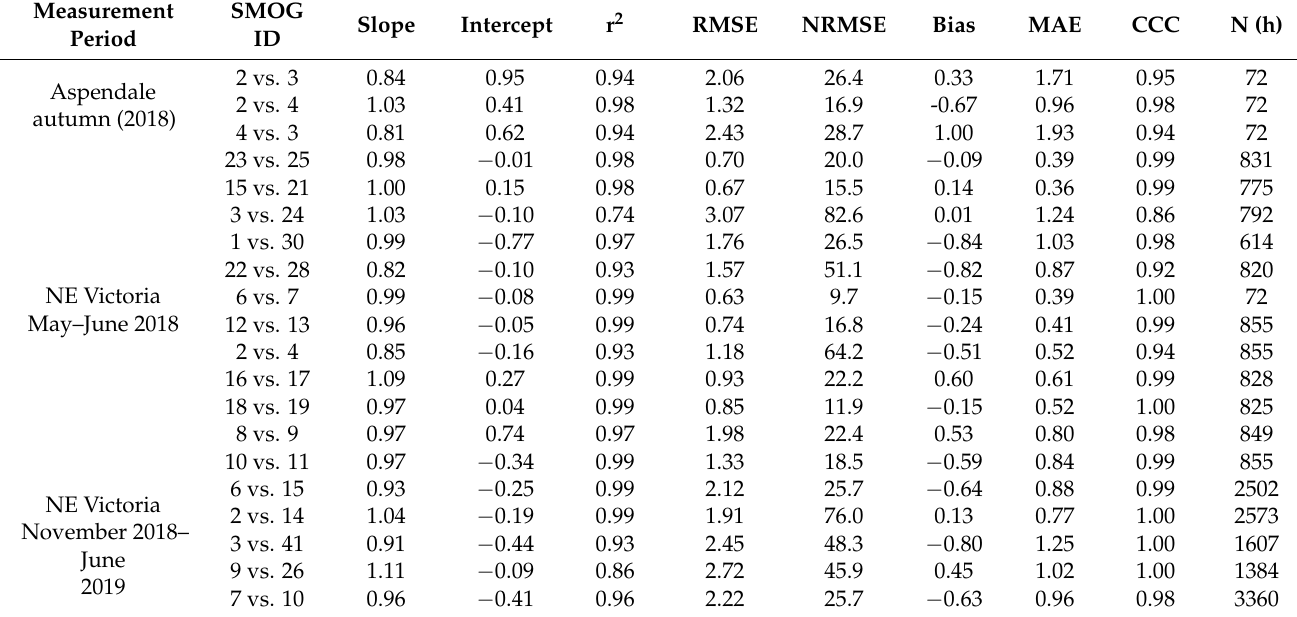
Table 2. Statistical metrics of SMOG